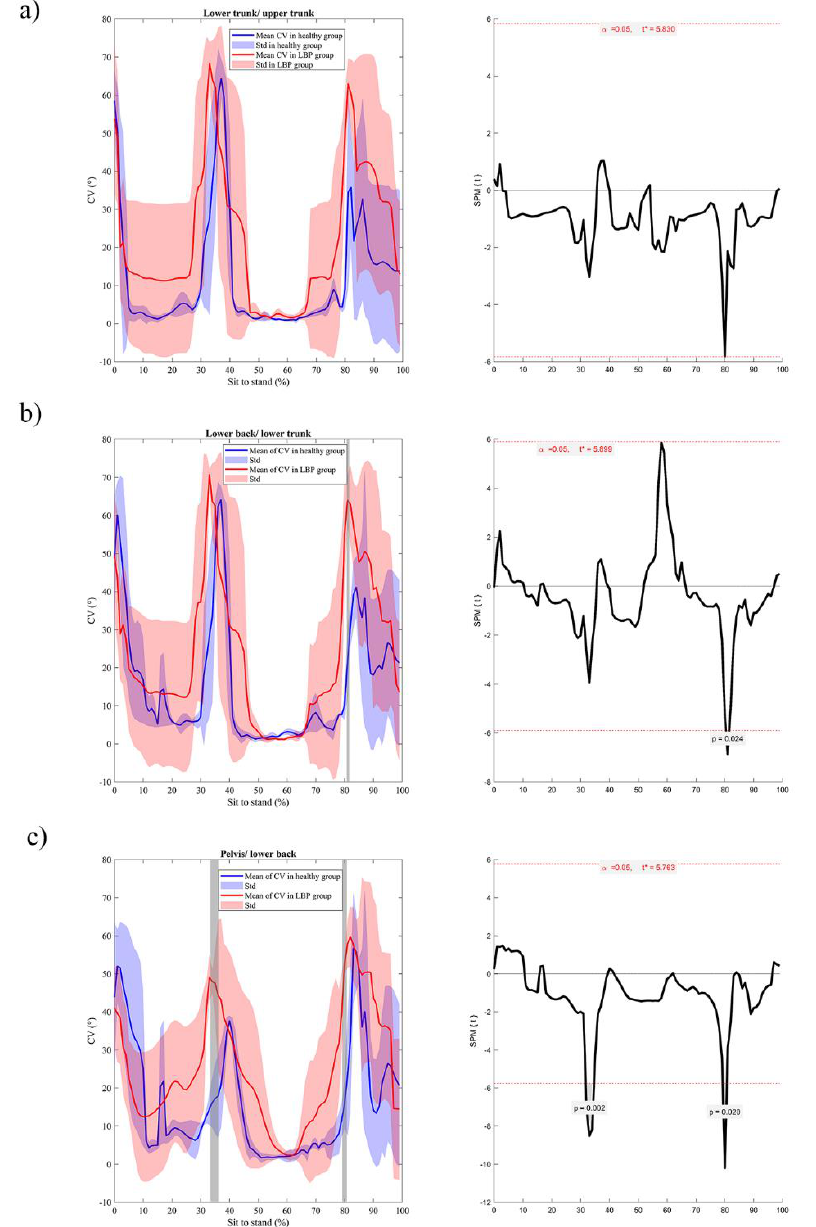
Figure 5. ( a ) LT/UT, ( b ) LB/LT, and ( c ) pelvis/LB coordination variability (CV) in the sagittal plane, and the results of an independent t -test using the SPM method during sit-to-stand, left side is the mean and standard diviation of CV and right side is the results of SPM analysis. Red dotted line in the SPM results in the critical threshold (t value).